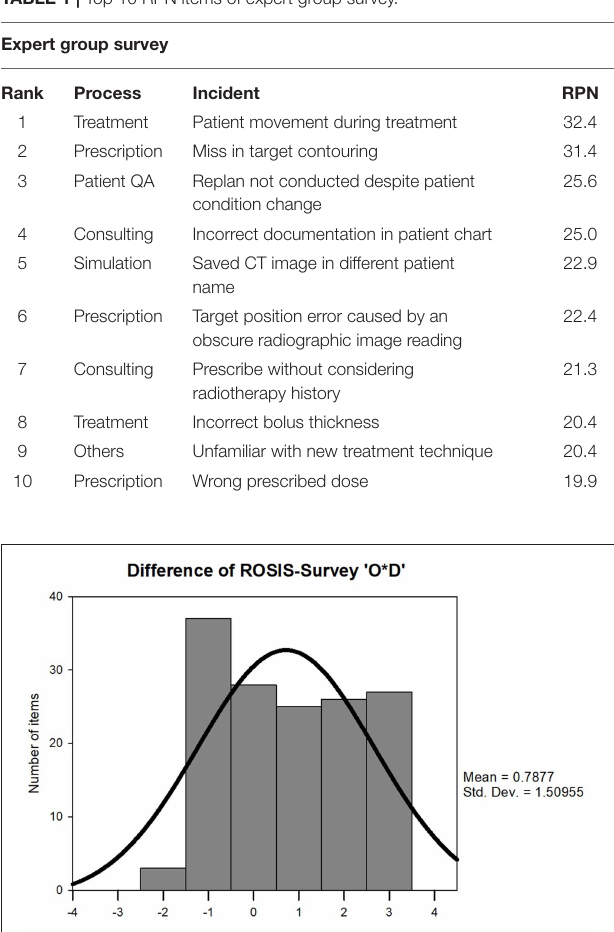
FIGURE 2 | Difference between ROSIS data and expert survey.